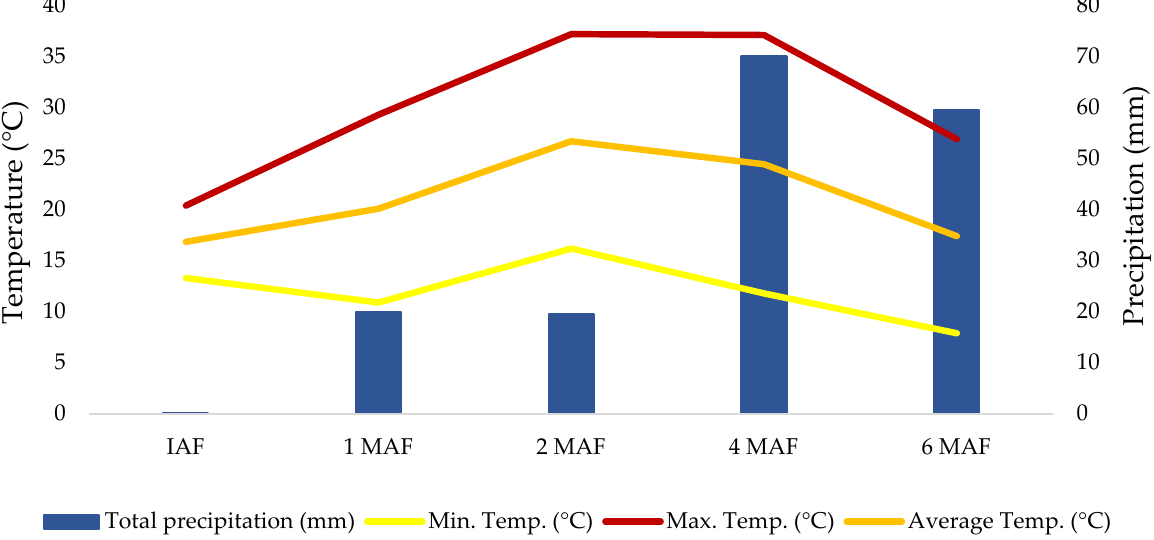
Figure 4. Monthly precipitation throughout the study period when sampling was maintained. Immediately after fi re: IAF, months after fi re: MAF.